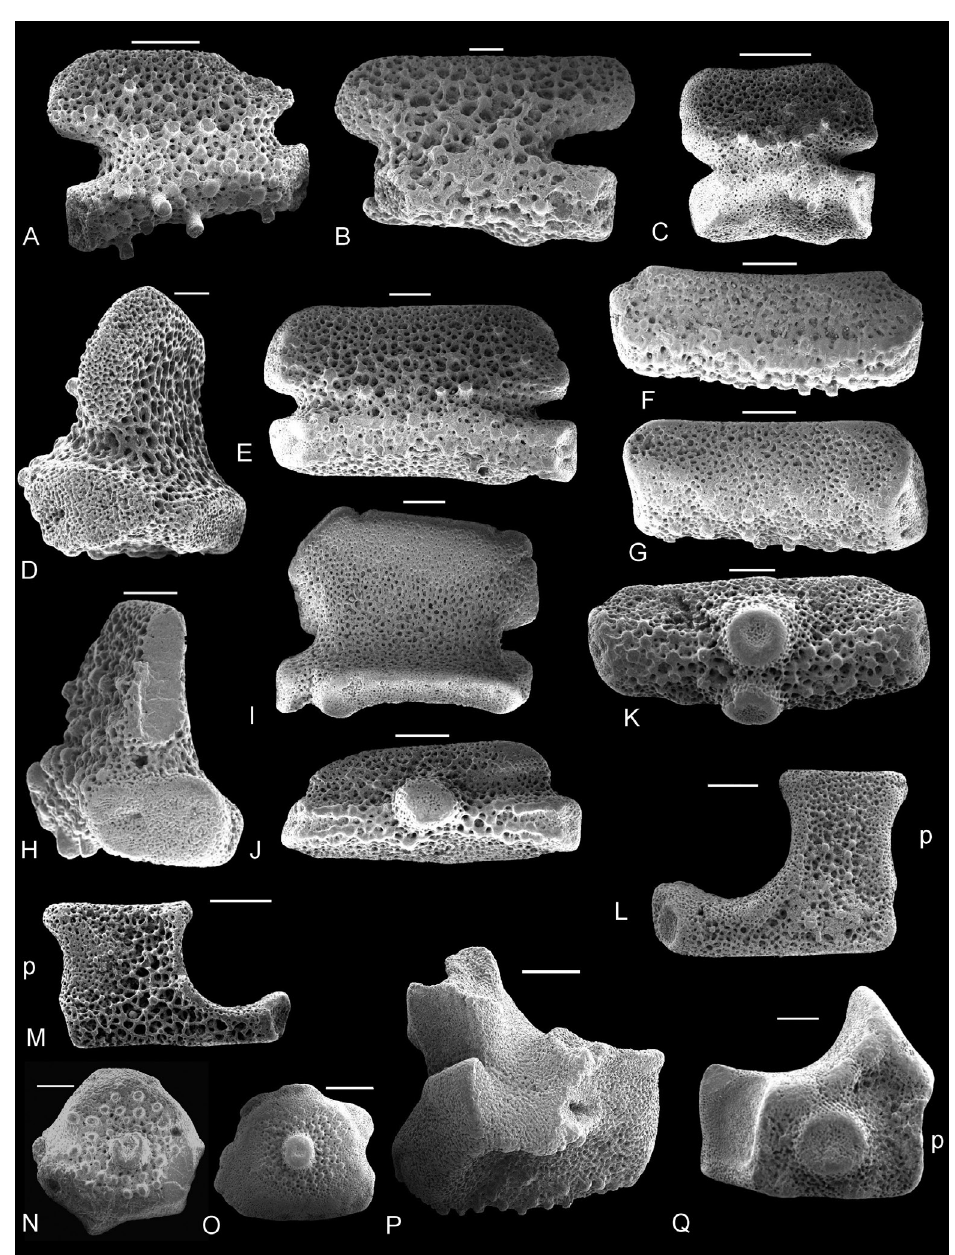
Fig. 12. A–I, L–M . Punkaster ruegenensis gen. et sp. nov. A–E, H–I . Fused marginal pairs, in lateral (A–C, E: SNSB-BGSP2020XLV 31–33, SNSB-BGSP2020XLV 35) views, at right angles to margin (D, H: SNSB-BGSP2020XLV 34, SNSB-BGSP2020XLV 38) views and internal view (I: SNSB- BGSP2020XLV 39). F–G . Distal inferomarginals in lateral view (SNSB-BGSP2020XLV 36–37). A . Holotype (SNSB-BGSP2020XLV 31). B–I . Paratypes (SNSB-BGSP2020XLV 32–39). L–M . Probable adambulacrals, actinal view (lot SNSB-BGSP2020XLV 32). — J–K . Punkaster spinifera gen. et sp. nov., marginals (SNSB-BGSP2020XLV 40–41). — N–O . Punkaster gen. nov., sp. indet., abactinal ossicles (SNSB-BGSP2020XLV 42–43). — P . ? Punkaster gen. nov., sp. indet., oral ossicle, external view (SNSB-BGSP2020XLV 44). — Q . Punkaster gen. nov., sp. indet., adambulacral, actinal view (SNSB-BGSP2020XLV 45). All specimens are from the upper lower Maastrichtian of Rügen, NE Germany. Abbreviation: p = proximal. See Fig. 3 for detailed morphological terminology. Scale bars: A, C–Q = 0.5 mm; B = 0.2